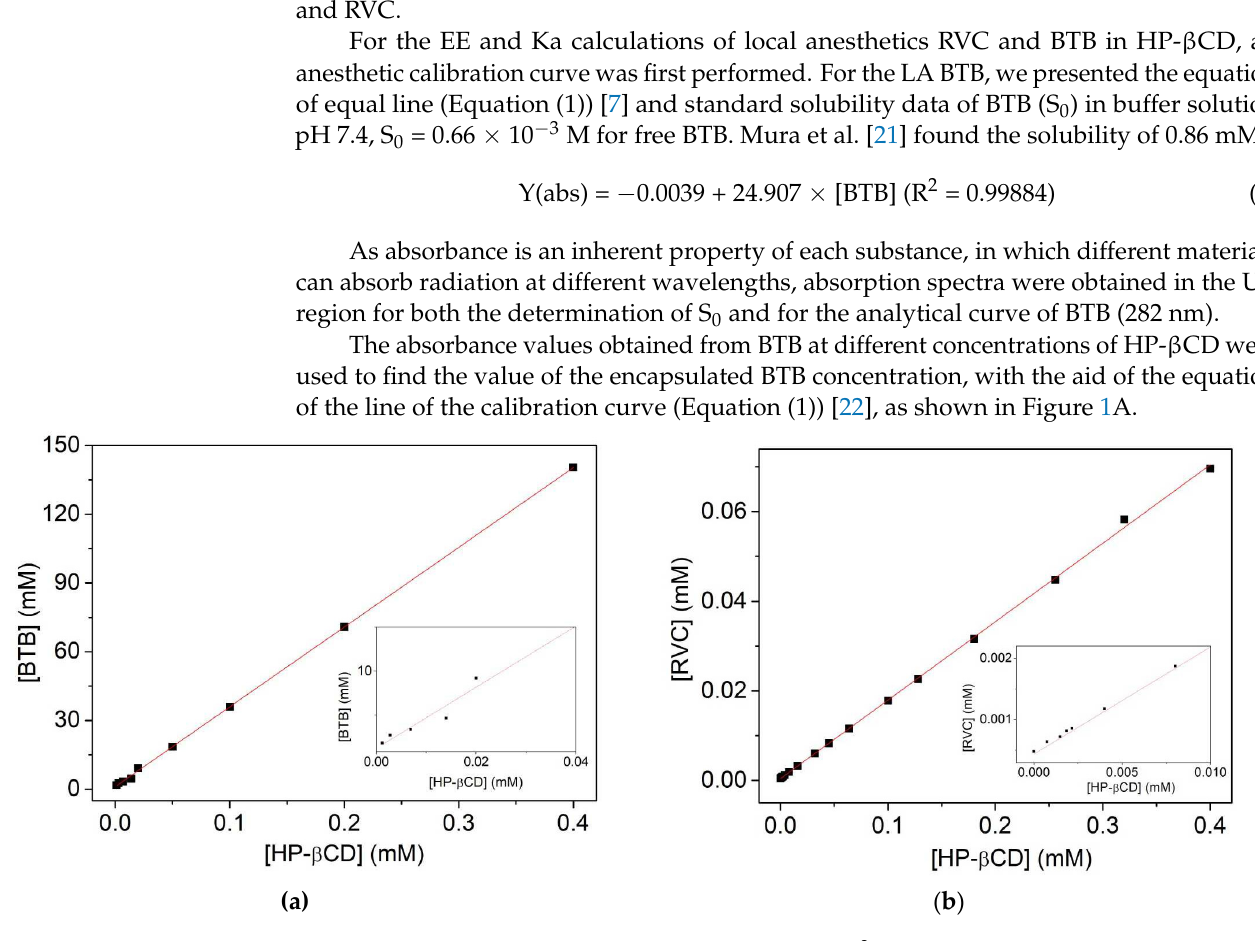
Figure 1. ( a ) BTB Solubility in HP- β CD (slope = 0.3479, R 2 = 0.99977); ( b ) RVC Solubility Graphic In HP- β CD (slope = 0.175, R 2 = 0.9994). Determined at room temperature (n = 3).